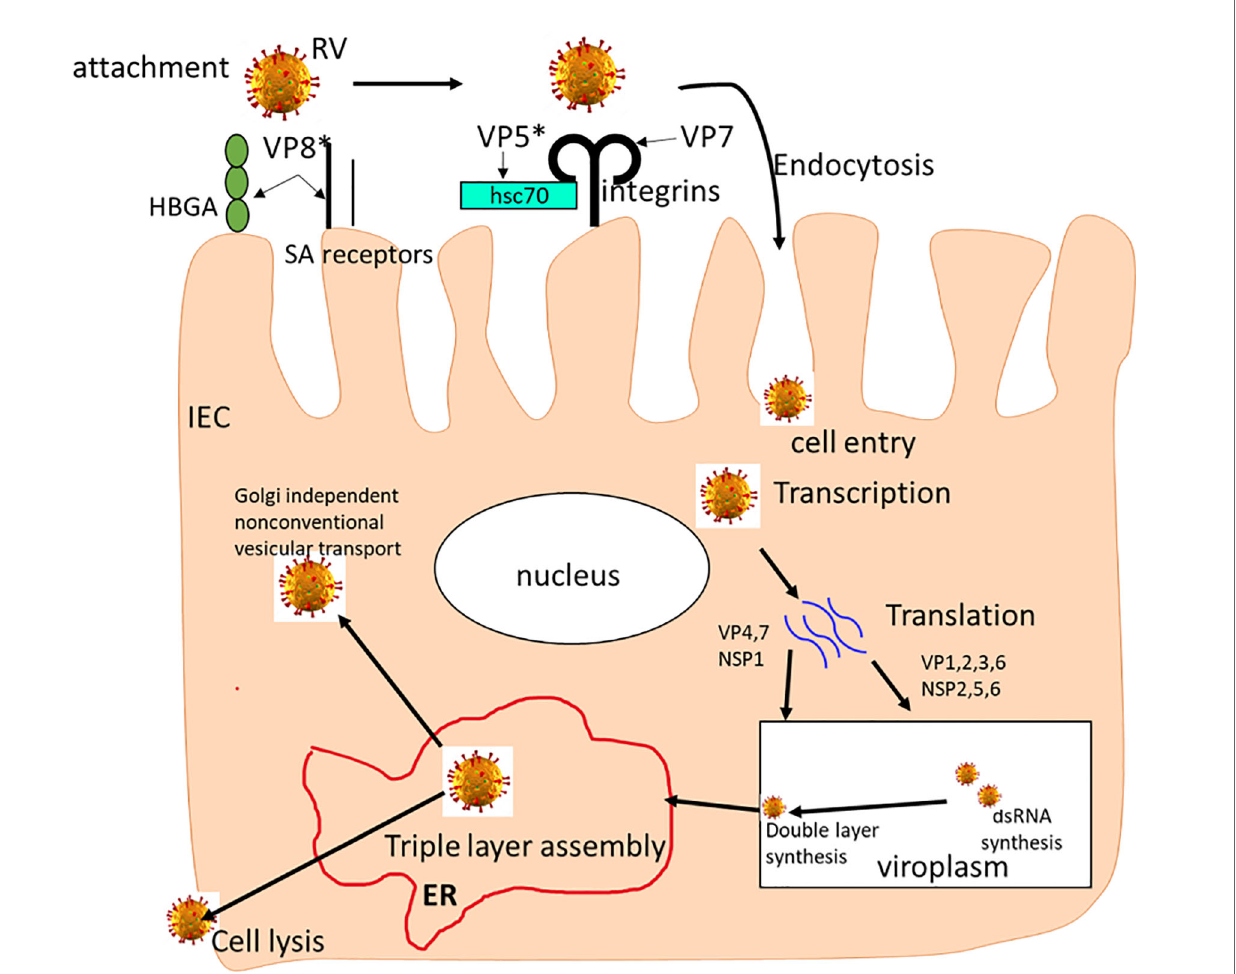
FIGURE 1 | The rotavirus replication cycle. The RV attaches to SAs and HBGAs on the host cell surface, then interacts with integrins and Hsc70 receptors where it is internalized by receptor-mediated endocytosis. Removal of the outer layer results in the release of double-layered particles (DLPs) in the cytoplasm where it undergoes mRNA transcription. mRNAs are translated into viral proteins, replicated and packaged viroplasms as DLPs. Then, the DLPs bind to NSP4 and bud into the endoplasmic reticulum (ER) where transient membranes are removed as VP4 and VP7 proteins assemble, leading to maturation of the TLP virion. The newly formed TLP virions are removed through cell lysis and in polarized epithelial cells, through Golgi-independent non-classical vesicular transport